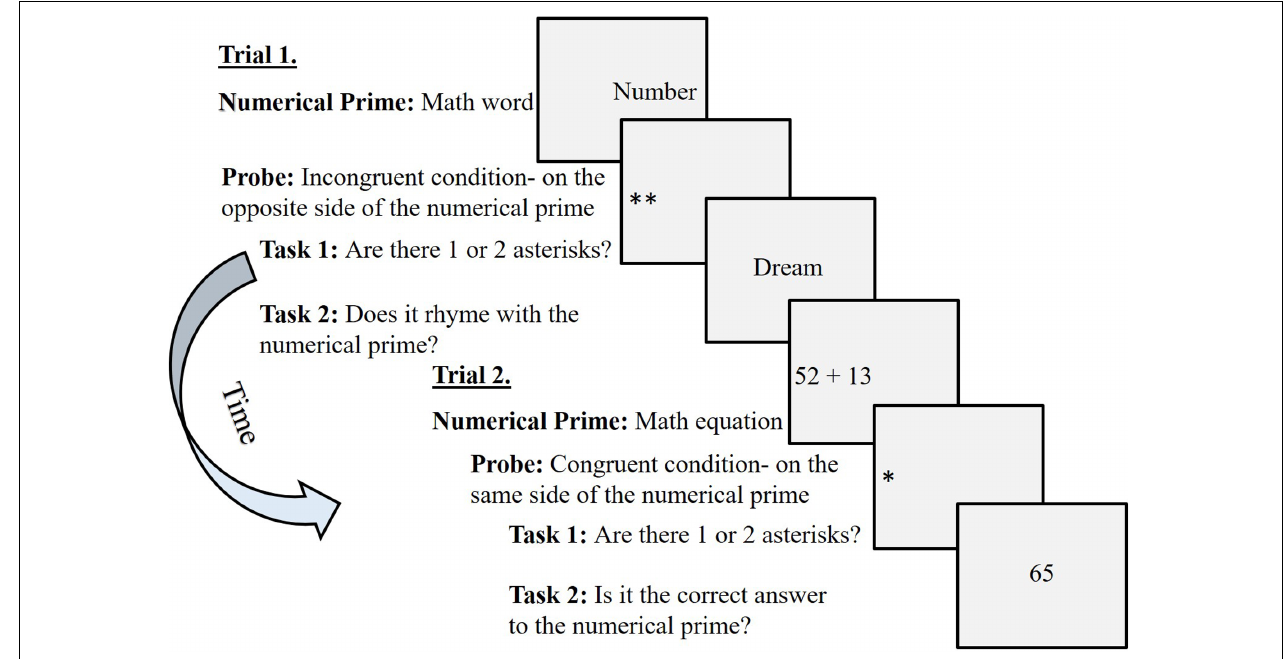
FIGURE 2 | Examples of trials in the numerical dot-probe task (Rubinsten et al.,